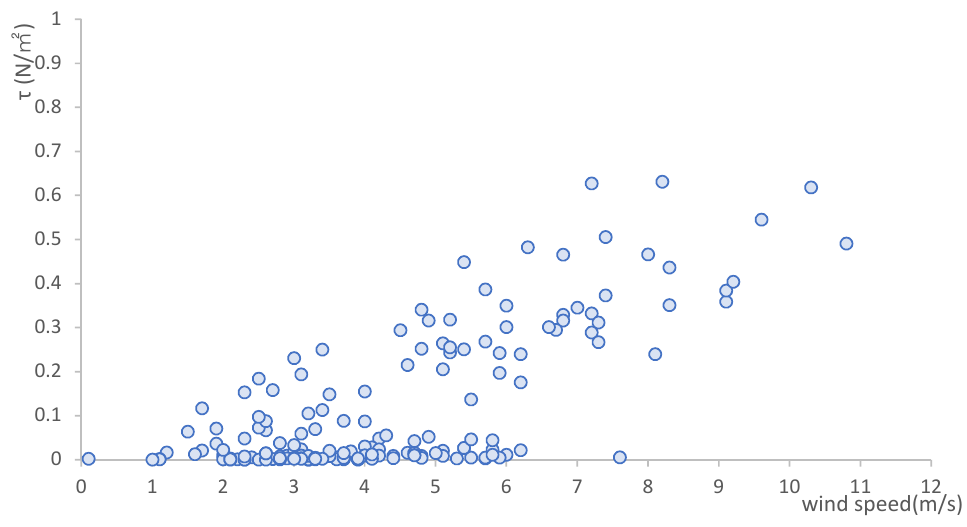
Figure 8. The relationship between the shear stress induced by wind and wind speed under natural conditions.